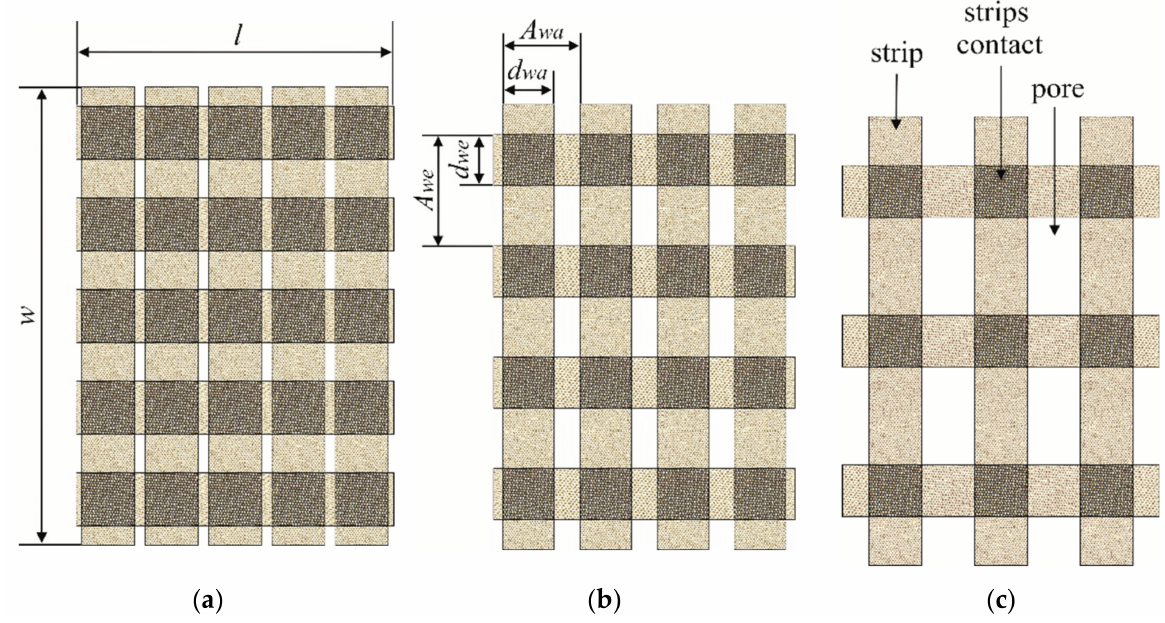
Figure 1. Woven structure types designed from strips: ( a ) 5 × 5; ( b ) 4 × 4; ( c ) 3 ×